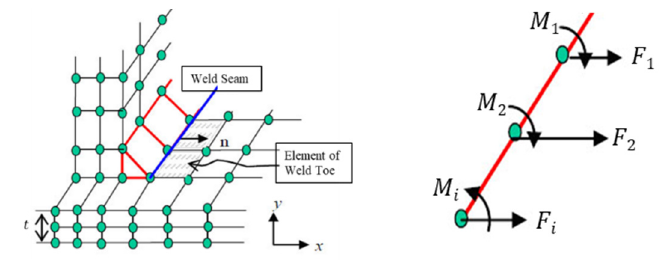
Figure 2. Nodal forces and moments of nodes of the weld seam and weld elements.